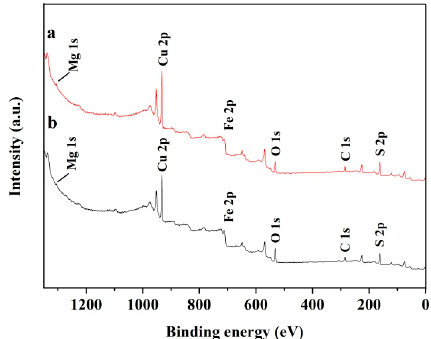
Figure 6. X-ray photoelectron spectroscopy (XPS) survey spectra of chalcopyrite surface in the presence of ( a ) 10 − 2 M and ( b ) 10 − 4 M Mg 2+ .